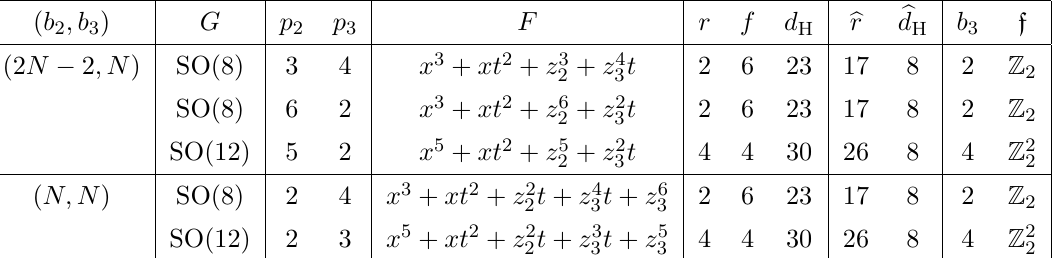
Table 16 . Sporadic models for G = SO( N ) . Note that there are only two inequivalent theories in the table above, and the one with r = 2 is the same as the rank-2 E